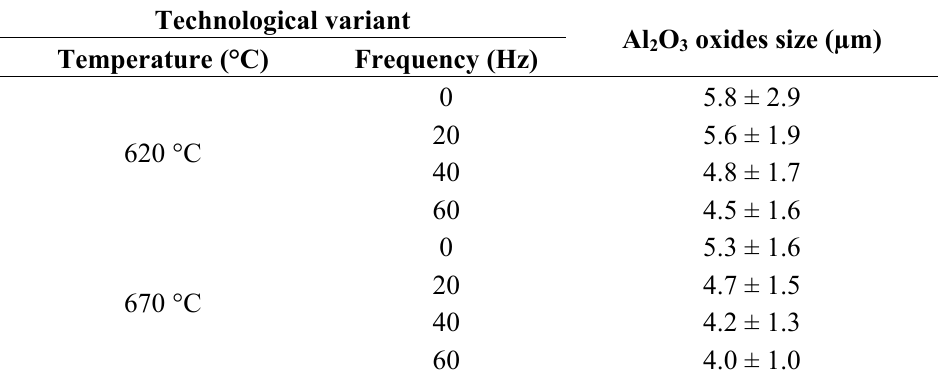
Table 2. Average equivalent diameter of Al 2 O 3 oxide particles (strengthening phase).